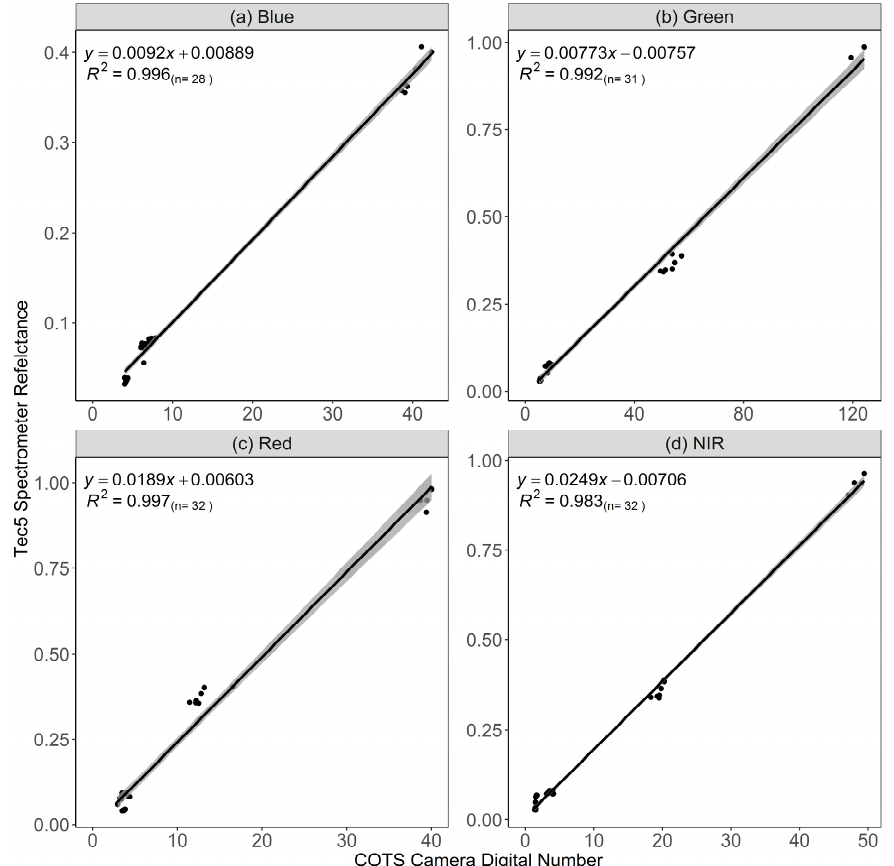
Figure 5. Results of relationships between exposure and vignetting corrected image DNs and Tec5 spectrometer reflectance in wavebands ( a ) Blue, ( b ) Green, ( c ) Red and ( d ) Near Infrared (NIR). All camera bands show strong linear agreements with Tec5 reflectance. Measurements of five black, grey and white spectral reflectance targets were used for